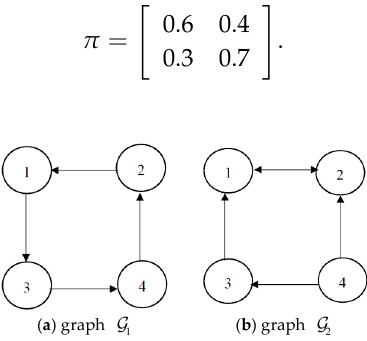
Figure 1. Two directed graphs, ( a ) graph G 1 and ( b ) graph G 2 .